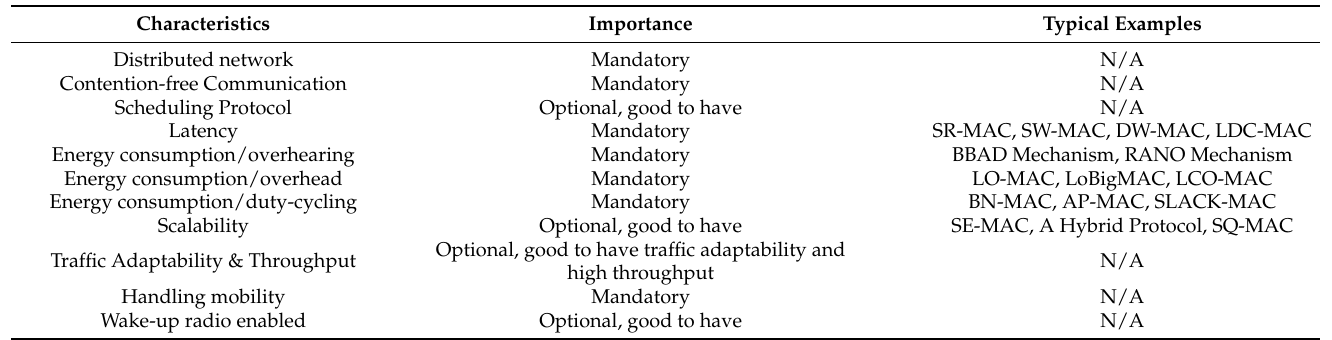
Table 1. Requirements for the desired MAC protocol design and related